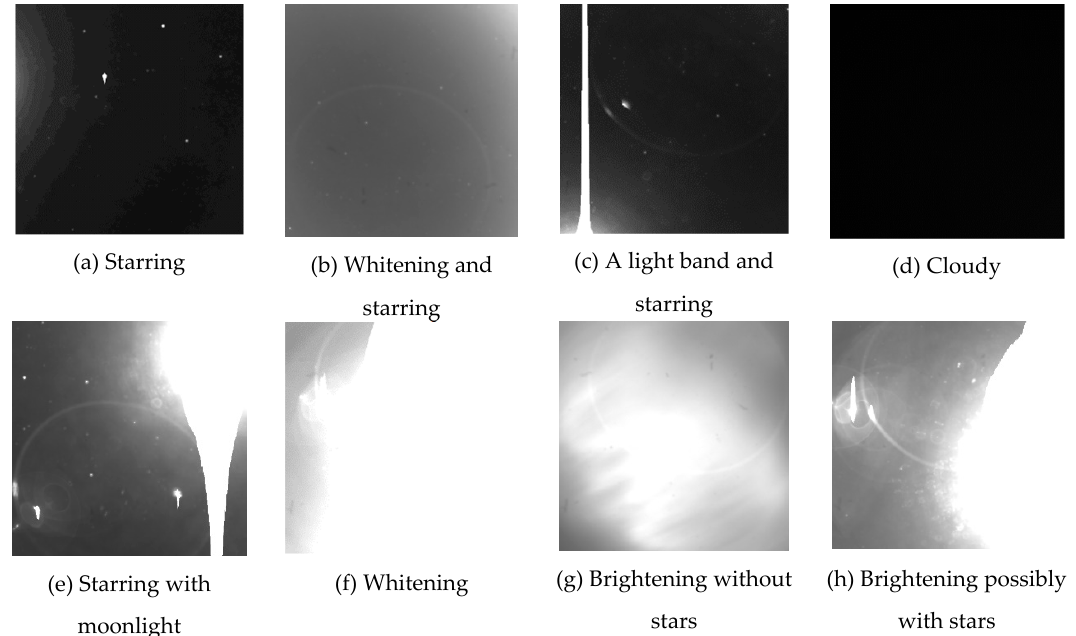
Figure 4. Eight categories of raw images: ( a ) Starring, a clear night sky with stars; ( b ) whitening and starring, a night sky with stars and whitened by the moonlight or twilight; ( c ) a light band and starring, starring with a light band caused by artificial light; ( d ) cloudy, a night sky fully covered by cloud; ( e ) starring with moonlight, a clear night sky with stars and moon in vision; ( f ) whitening, a night sky with full moon or camera overexposure; ( g ) brightening without stars, the moon behind the cloud; and ( h ) brightening possibly with stars, starring but partly overexposed.